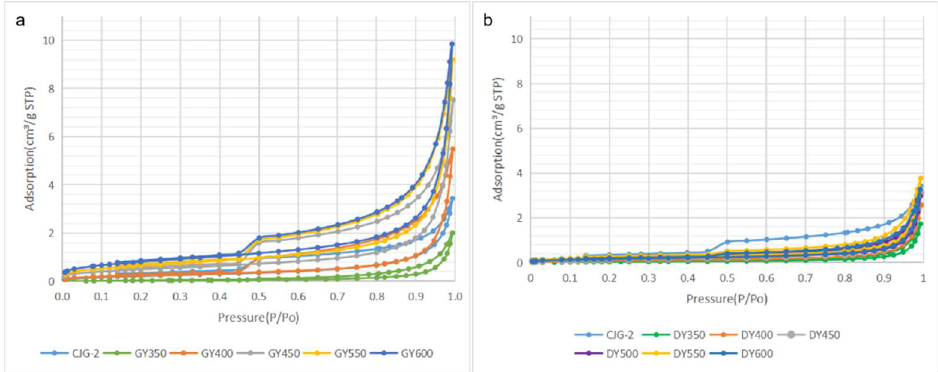
Figure 10. Nitrogen adsorption and desorption curves. ( a ) Semiclosed and ( b ) open systems.